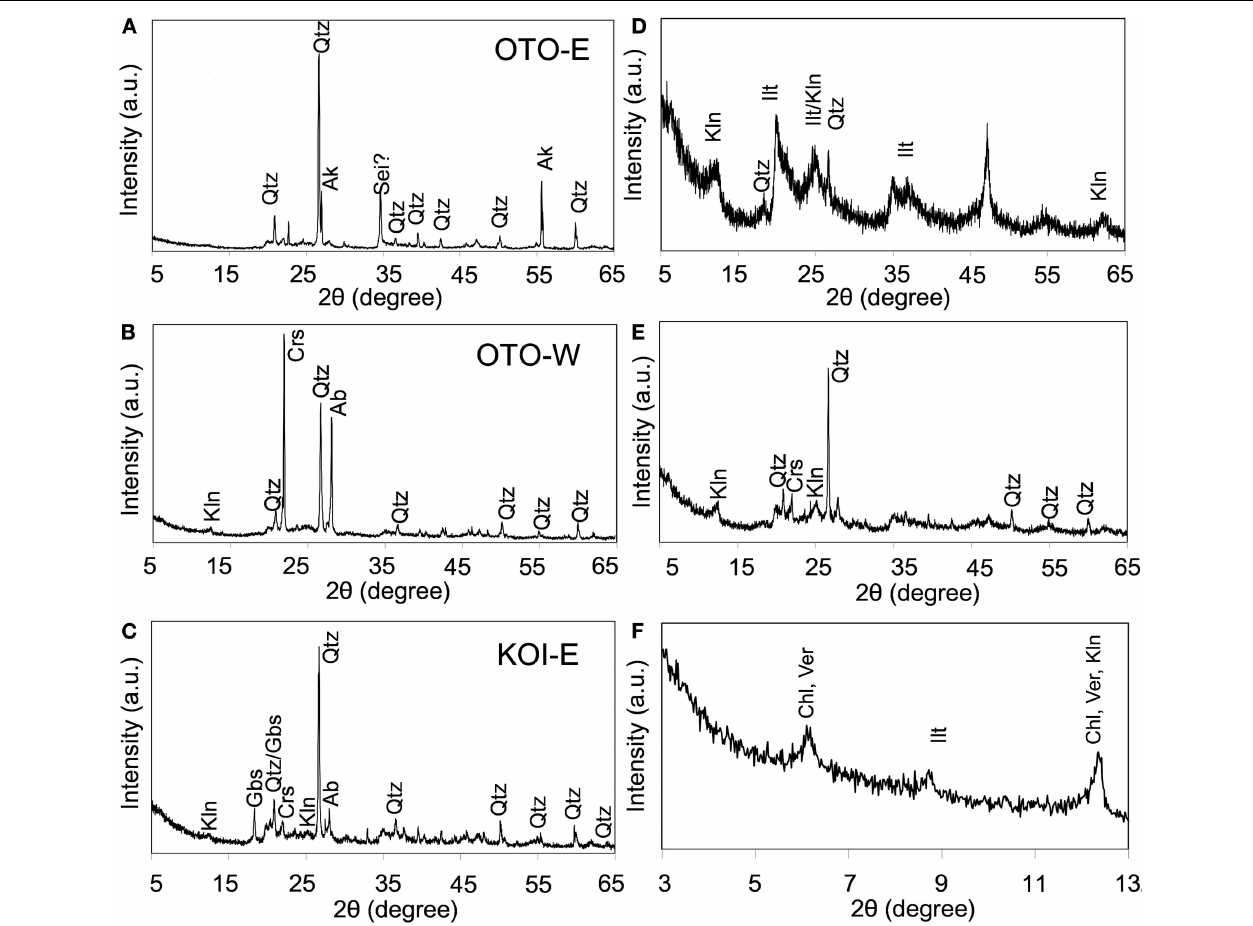
FIGURE 4 | X-ray diffraction spectrum of three soil samples: OTO-E, OTO-W, and KOI-E . (A–C) The patterns obtained from the bulk samples. (D–F) The patterns obtained from submicron-sized particle after elutriation of